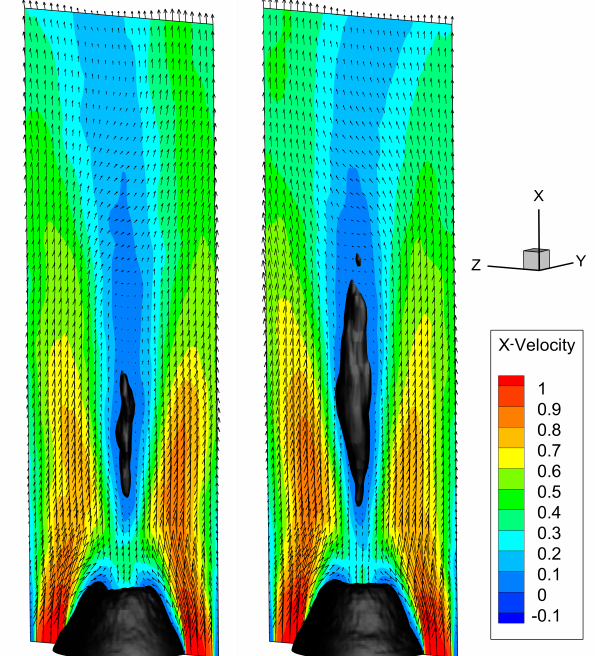
Figure 7. Reconstruction of the axial velocity fields ( m / s ) by 3D ROM using the first mode pair ( St = 0.0311), with a black isosurface of zero axial velocity and the velocity vectors shown. Left : Reconstruction with the minimal temporal coefficient. Right : Reconstruction with the maximal temporal coefficient.